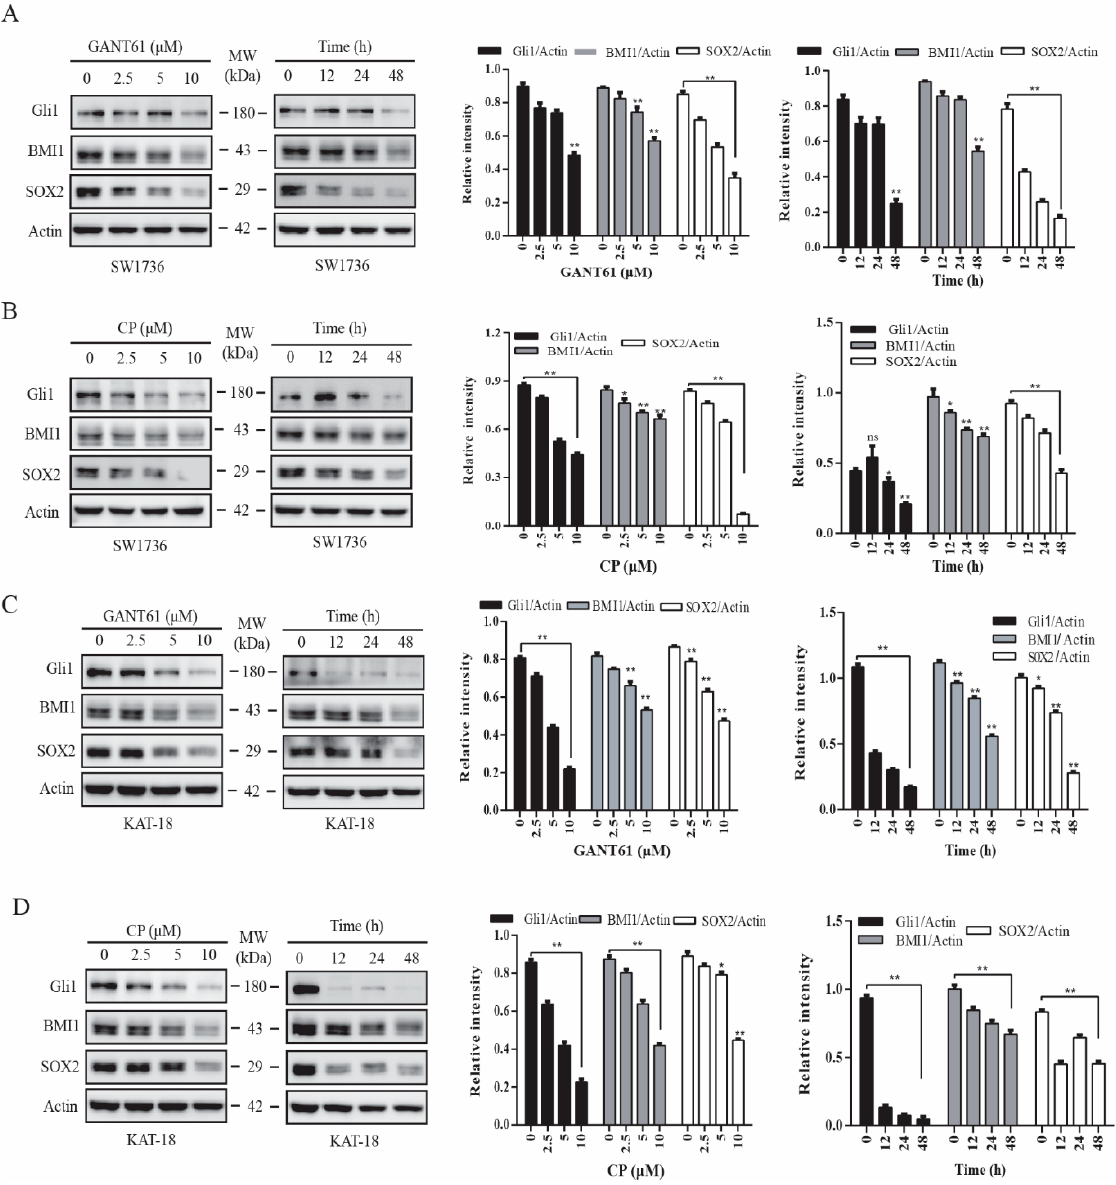
Figure 1. Inhibition of the sonic hedgehog (Shh) pathway suppressed BMI1 and SOX2 expression. SW1736 ( A , B ) and KAT ‐ 18 ( C , D ) cells were incubated for 48 h in the absence or presence of the indicated concentrations of cyclopamine or GANT61 or incubated with GANT61 (10 μ M) ( A , C ) or cyclopamine (CP) (10 μ M) ( B , D ) for the indicated lengths of time. Cell lysates were prepared and analyzed for Gli1, BMI1, SOX2, and actin expression by Western blot. Relative protein levels were analyzed by quantification of the density of the protein bands with NIH Image ‐ J software and presented as bar graphs. Data are mean ± standard deviation (SD) of three experiments. * p < 0.05, ** p < 0.01, compared to untreated control. ns: not significant.